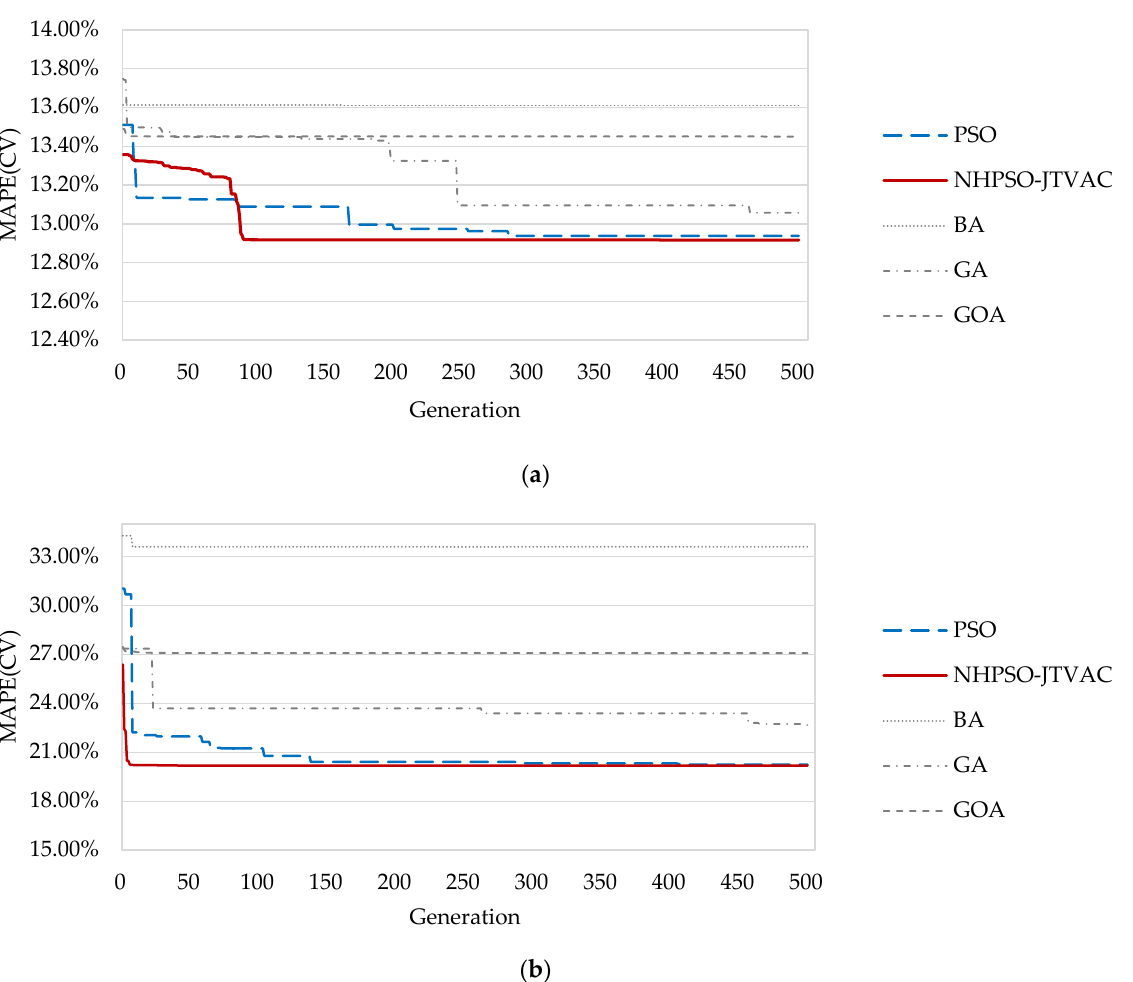
Table 5. K-fold CV scores (MAPE) of each model.